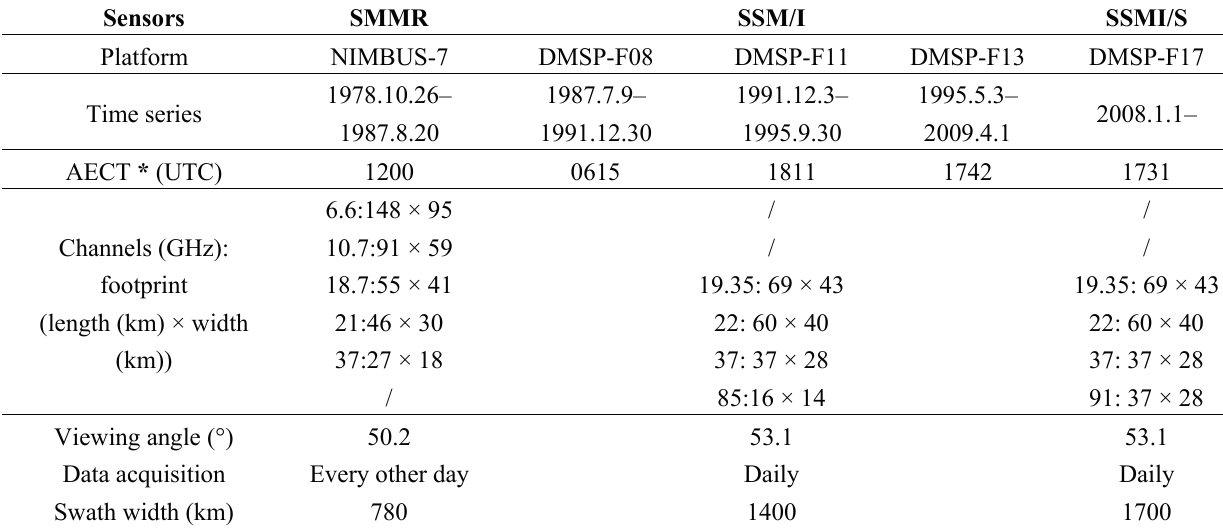
Table 1. Parameters of passive microwave sensors on various satellites.